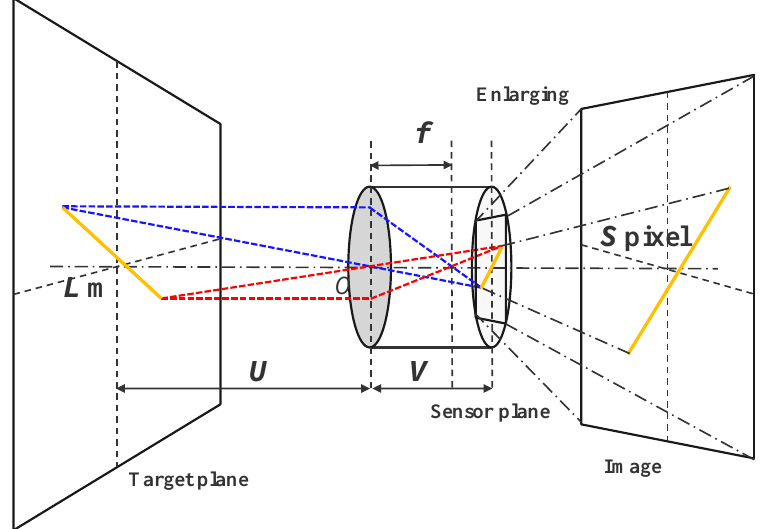
Figure 1. Imaging geometrical relationship of Gauss model.